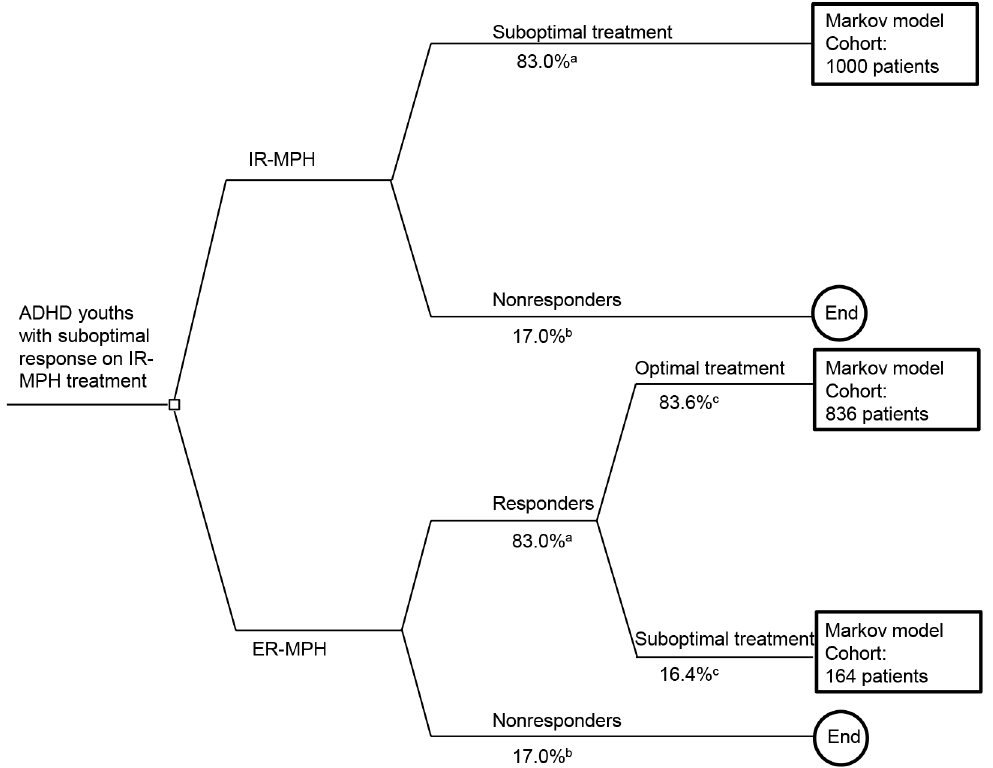
Fig 1. Decision tree of the exploratory initial two-month phase prior to the Markov model. a. Source: Expert panel Faber et al. (2008)[2] b. Source: Expert panel Faber et al. (2008)[2] c. Source: Gau et al. (2008)[17]